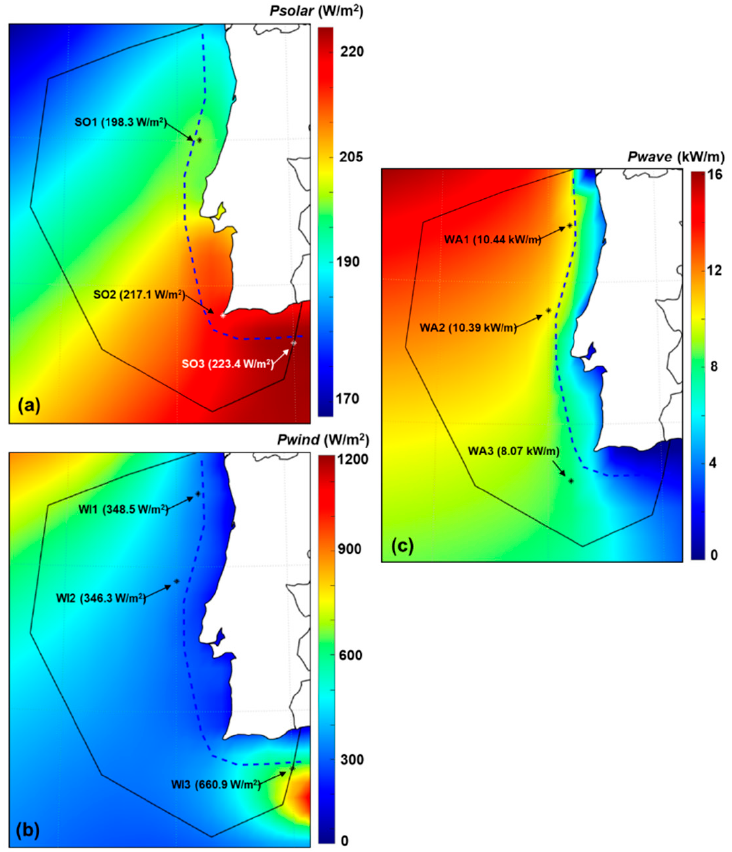
Figure 5. Spatial distribution of the marine resources (average values) near the Portuguese coastal area. Results based on 10 years of ERA5 data (from 2012 to 2021), where: ( a ) solar power; ( b ) wind power; ( c ) wave power. The local maximum values are also indicated for each sector (north–1; center–2; south–3).